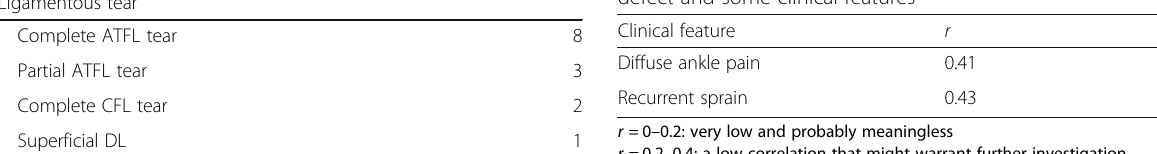
Table 6 Correlation between presence of OCL or chondral defect and some clinical features